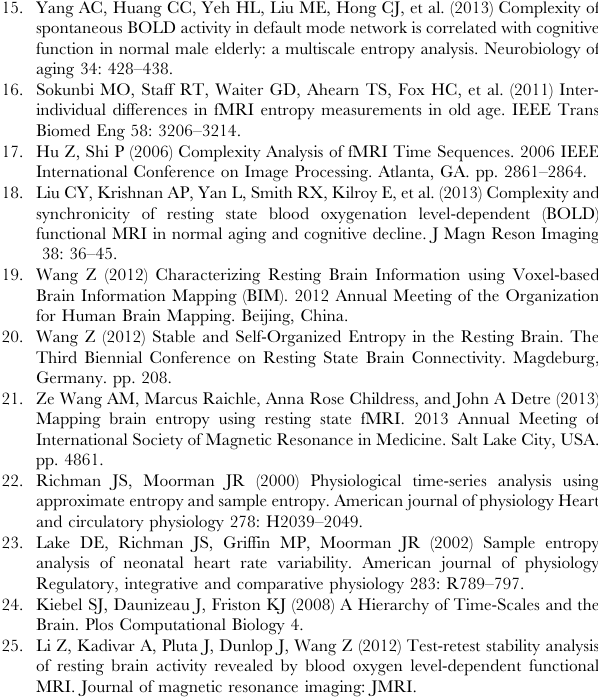
Figure S1 SampEn evaluation results. A) waveforms of a Gaussian noise, a chirp signal, and a sinusoidal signal used for evaluating SampEn; B) SampEn calculation results using different embedded dimensions (m) and different tolerance levels (r) with different data length; C) the hemodynamic response function (HRF)-convolved artificial brain activation (the red line) and noise (the blue line); D) SampEn of noise (blue lines) and noise contaminated brain activation (red lines). The errorbars indicate standard error of SampEn for each calculation. Figure S2 Brain activations identified using standard general linear model. The task activation was defined as the significant brain activity magnitude between the task condition and control condition. The significance level used here is the same as that in Fig. 1C. Red and green indicate results of the first and second day sensorimotor task performing experiment. Colorbar means the t-value range of the statistical parametric maps shown here. Figure S3 Mean resting BEN maps of 1049 subjects calculated using SampEn with m = 3, r= 0.4, 0.6, 0.8, 1 from the bottom row to the top row, respectively. For the purpose of display, every BEN map has been normalized to be from 0 to 1 (divided by its maximum intensity). The colormap shows the display window used for generating the maps and its range is from 80% to 101% of the maximum. Figure S4 Silhouette coefficient (red line) and the number of non-reproducible clusters (blue line) of BEN clustering using different pre-specified cluster numbers.